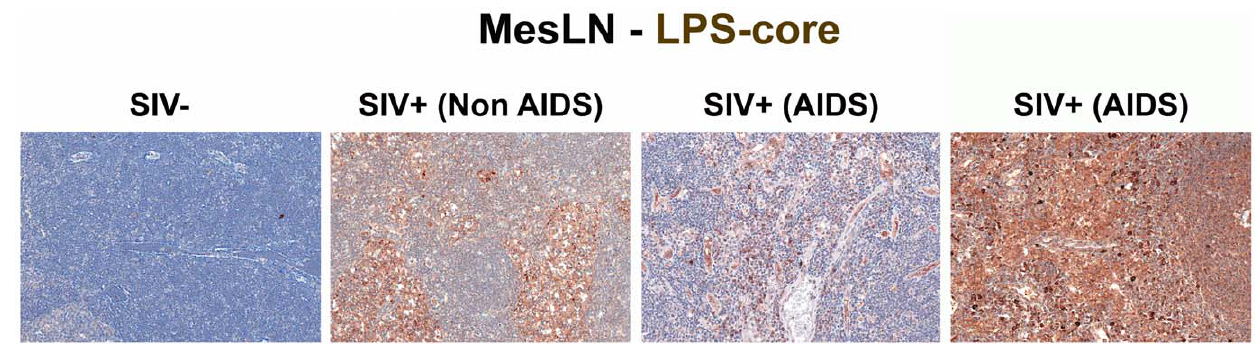
Figure 3. Identification of microbial translocation in gut draining MesLN of chronically SIV + RMs. Representative images (200 6 ) of the paracortical T-cell zone of MesLN stained for LPS-core antigen (brown). Note the more extensive accumulation of microbial products within the T cell zone, the T-cell inductive parenchyma of the lymphatic tissue with progressively more severe SIV infection.